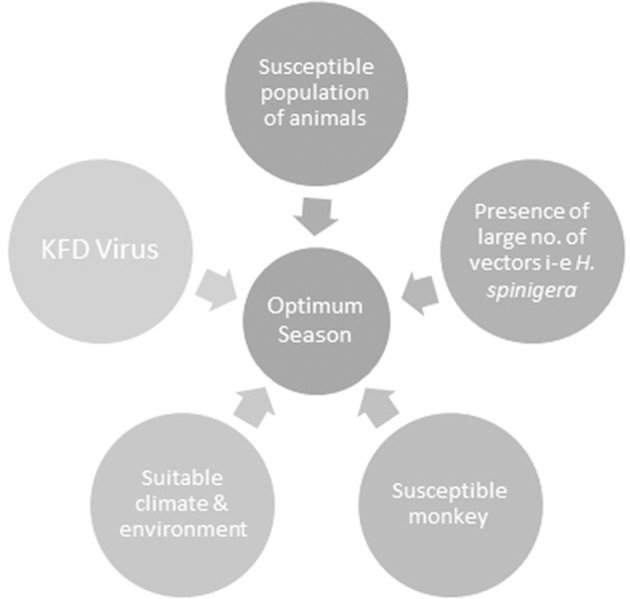
The confluence of factors responsible for Kyasanur Forest disease (KFD). All of these factors when present in right proportions result in an optimum season for the development of KFD.